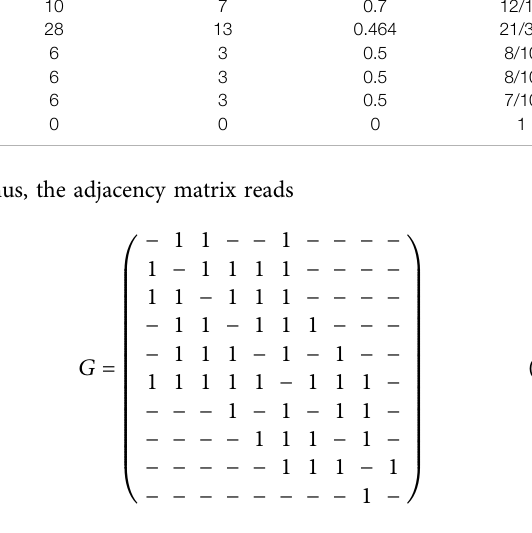
TABLE 1 | Characteristics of the network matrix G , with hereby de fi ned node ( i ) notations (Hokm. = Hokmah; Geb. = Gebourah; Tiph. = Tiphereth; and Malk. = Malkouth) in the fi rst and second columns, and their corresponding number of links ( d ] vertex ] i hasadegree d ] ; q i isfullyde fi nedin Eq.8 intermsof p i andthe i vertexdegree d ] i triads (